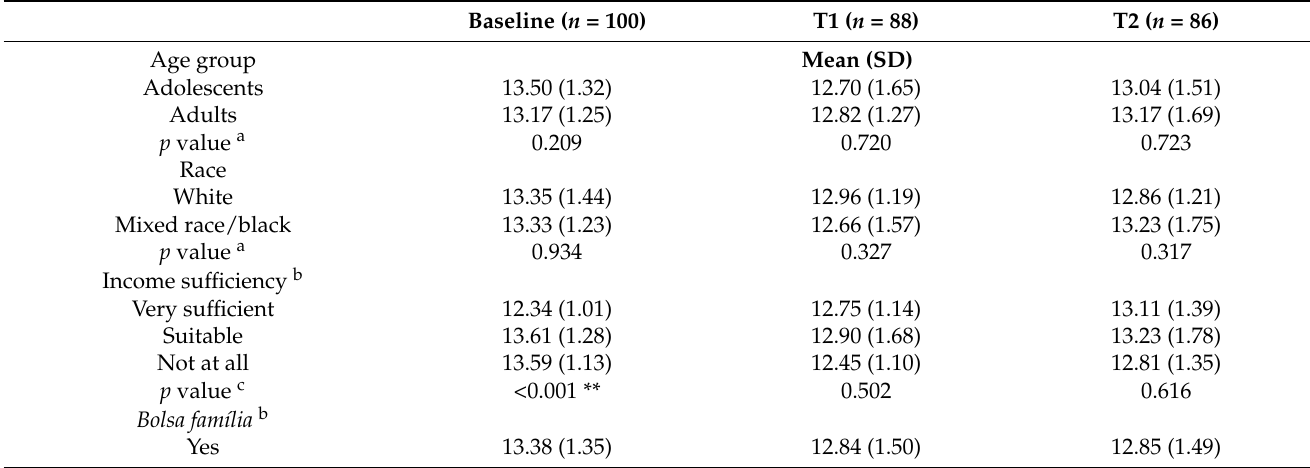
Table 2. Means (SD) of THB according to the independent